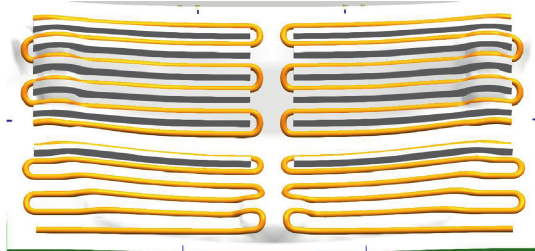
Figure 5: Distribution of formwork cooling water